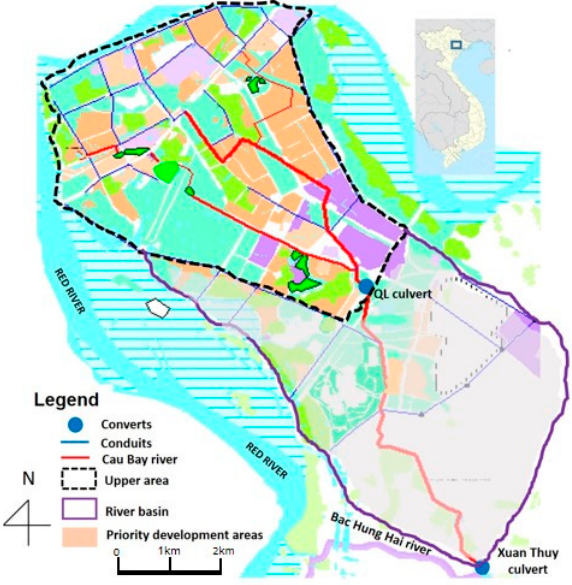
Figure 1. Map of the study area.